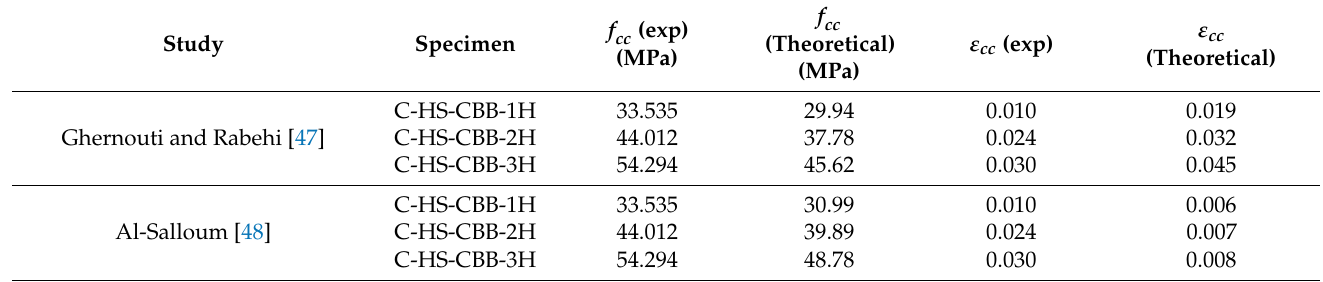
Table 7. Comparison of experimental and analytical results for confinement of Type-2 concrete